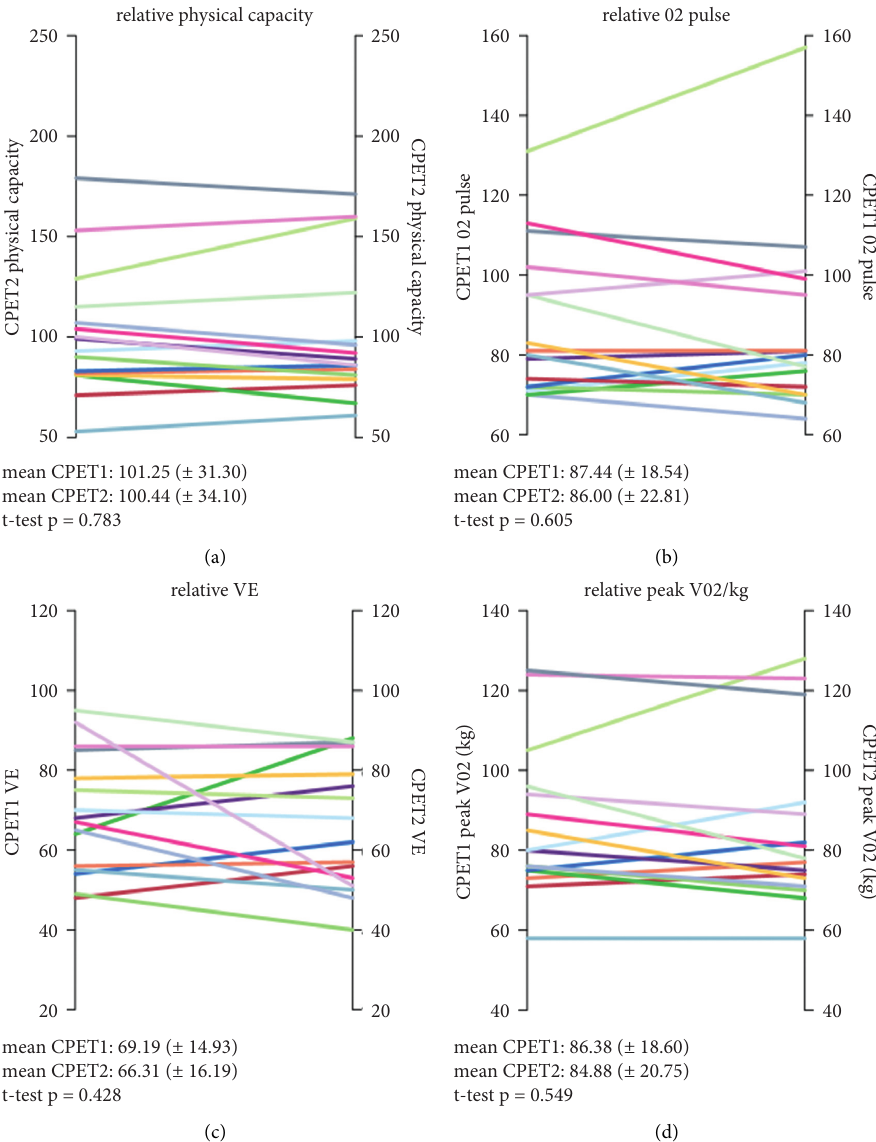
Figure 2: Physical capacity, O ̇ E, and peak V ̇ O 2 pulse, V 2 /kg at first and second CPET (in %). Analysis performed with Student’s t -test for related variables; mean value ( ± standard deviation). V ̇ E: respiratory minute volume and peak V ̇ O 2 /kg: body weight-indexed oxygen